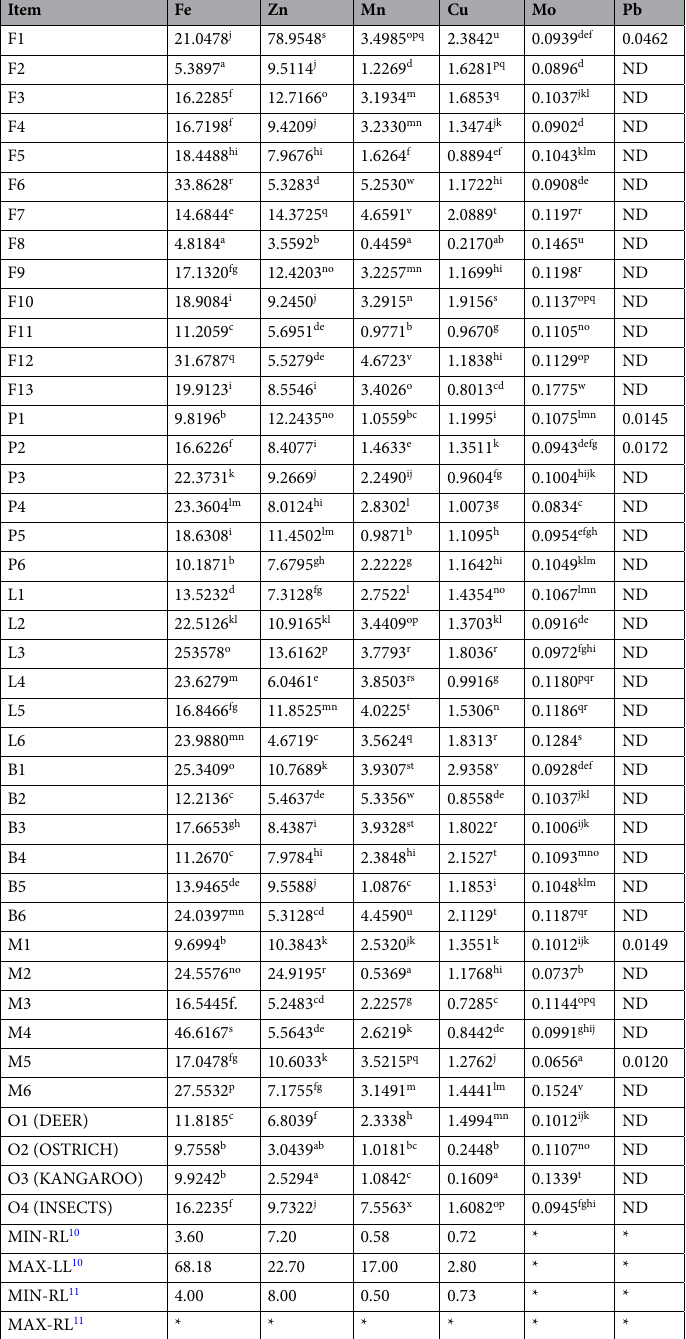
Table 3. Content of trace elements and heavy metals (mg/100 g DM) in analyzed dry dog foods. DM, dry matter; MIN-RL, minimum recommended level; MAX-LL, legal limit; ND, not detected; F, foods with fish; P, foods with poultry; L, foods with lamb; B, foods with beef; M, mixed foods; O, other foods; means with at least one same letter in the superscript (a, b, c, …) not differ statistically at P = 0.05 (for all columns separately). * No